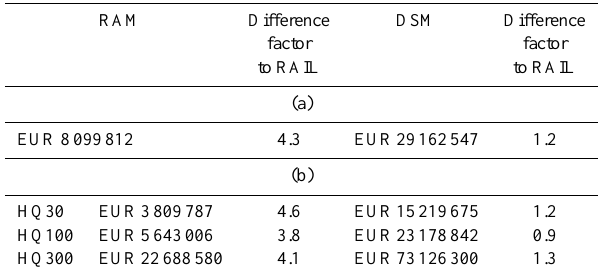
Table 4. (a) Calculated monetary losses for the March flood in 2006 according to the Rhine-Atlas Model (RAM) and the Damage Scan- ner Model (DSM). (b) Calculated monetary losses for the synthetic flood scenarios according to RAM and